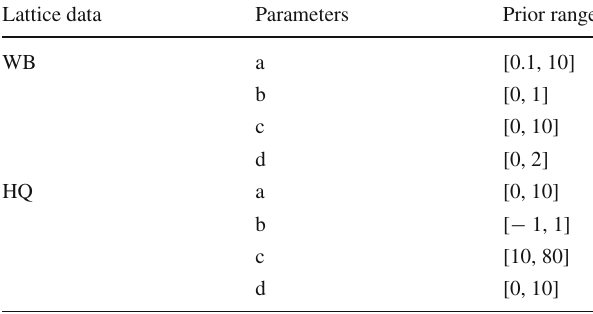
Table 1 The ranges of model parameters ( a , b , c , d ) used in the prior